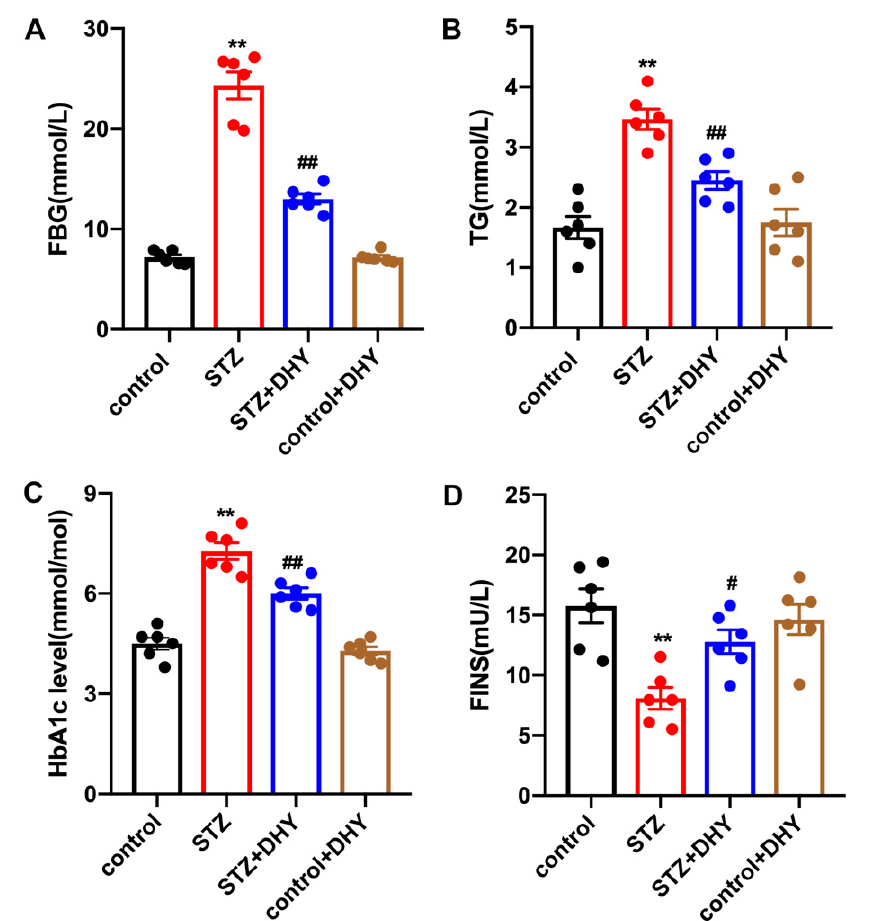
Figure 1. DHY alleviated FBG, TG and HbA1c levels and increased FINS in STZ-induced C57BL/6 mice. Male C57BL/6 mice (8 weeks old) were intraperitoneally injected with streptozotocin (STZ, 60 mg/kg/day) for 5 consecutive days. Mice in control group were injected with the same amount of citrate buffer. DHY (250 mg/kg) or carboxymethylcellulose (CMC, 0.5%) were administrated 2 weeks later, once daily by gavage for 12 weeks. ( A ) FBG level. ( B ) TG level in the serum. ( C ) HbA1c level in the plasma. ( D ) FINS level. ** p < 0.01 versus control, # p < 0.05, ## p < 0.01 versus STZ, n = 6.